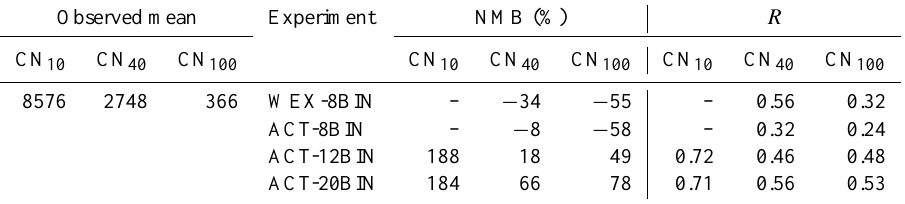
Table 7. Summary statistics for CN 10 , CN 40 and CN 100 when using the ACT parameterization in a sectional framework with different numbers of particle size bins together with statistics for default configuration of WRF-Chem (WEX-8BIN). It should be noted that WEX- 8BIN statistical results are the same as the 8BIN simulation presented in Tables 1 and 2. The observed mean, normalized mean bias (NMB) and correlation coefficient ( R ) are calculated between simulated and observed number concentration at the T0 site during the 7–16 June 2010 period.